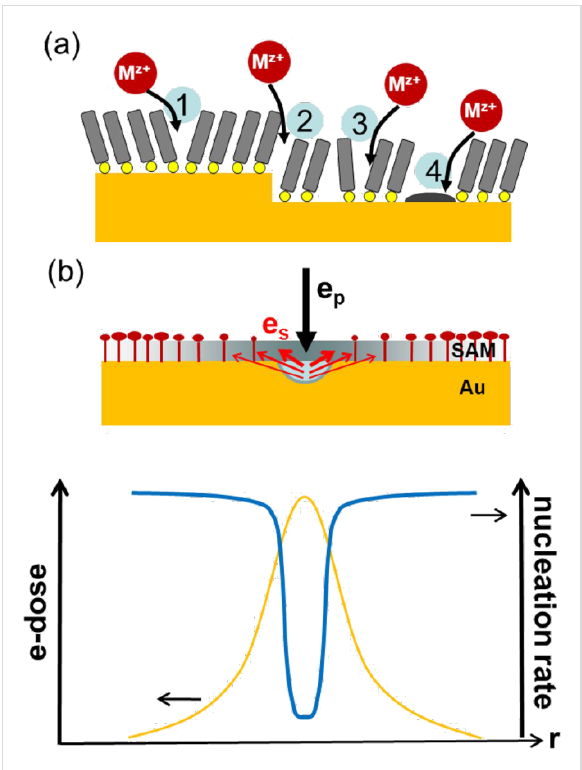
Figure 2: (a) Illustration of different types of defects in a SAM. Domain boundaries (1) and substrate steps (2) as intrinsic defects; missing molecules (3) and contaminations (4) as extrinsic defects. (b) Metal electrodeposition on a negative-resist SAM patterned by e-beam litho- graphy. Top: A primary e-beam, e p , generates a spatial profile of sec- ondary electrons, e s . The resulting gradient in the cross-linking of the SAM yields a gradient in the density of nucleation sites for the metal mushrooms. Bottom: Illustration of the inverse relationship between ir- radiation dose and nucleation rate.